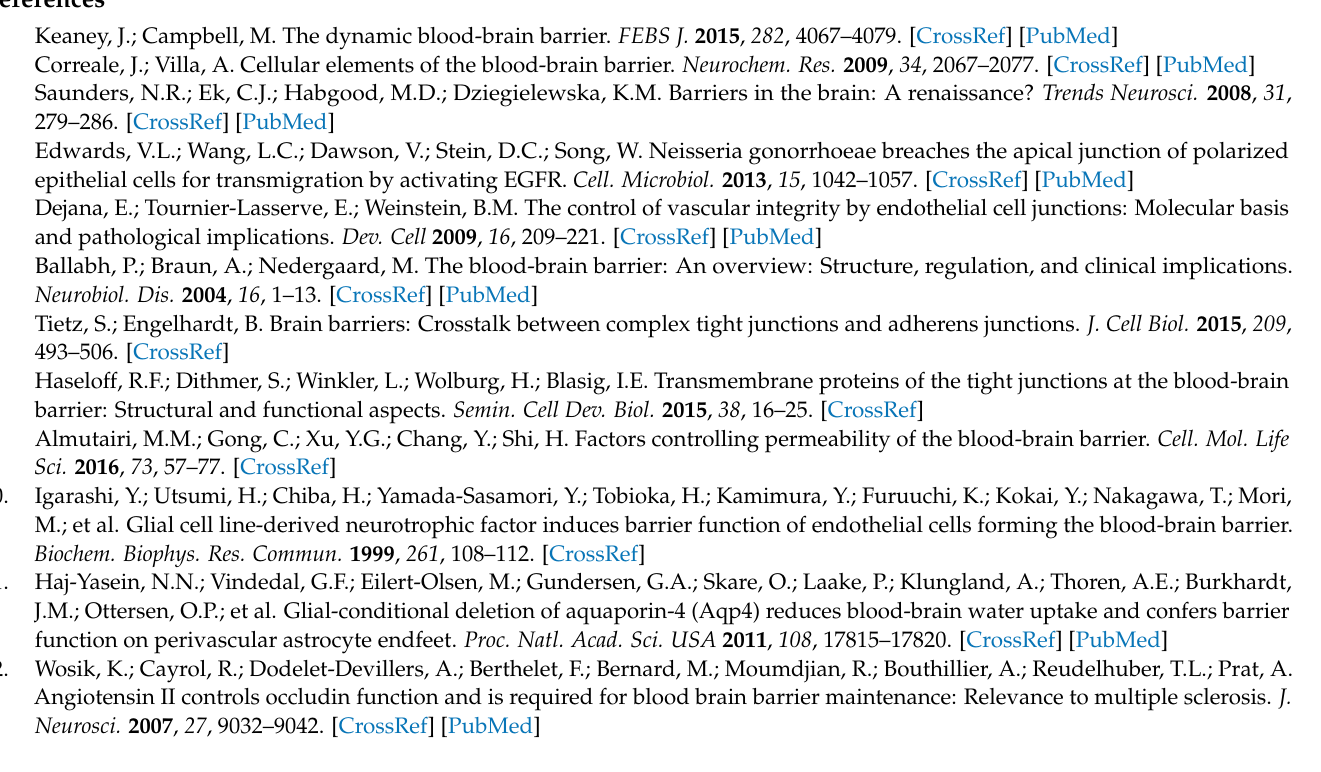
Table S1: Primers used for the qPCR assays. Table S2: Primers for CDS cloning and promotor region amplification in the dual-luciferase reporter assays. Table S3: Primers used in ChIP-PCR/qPCR